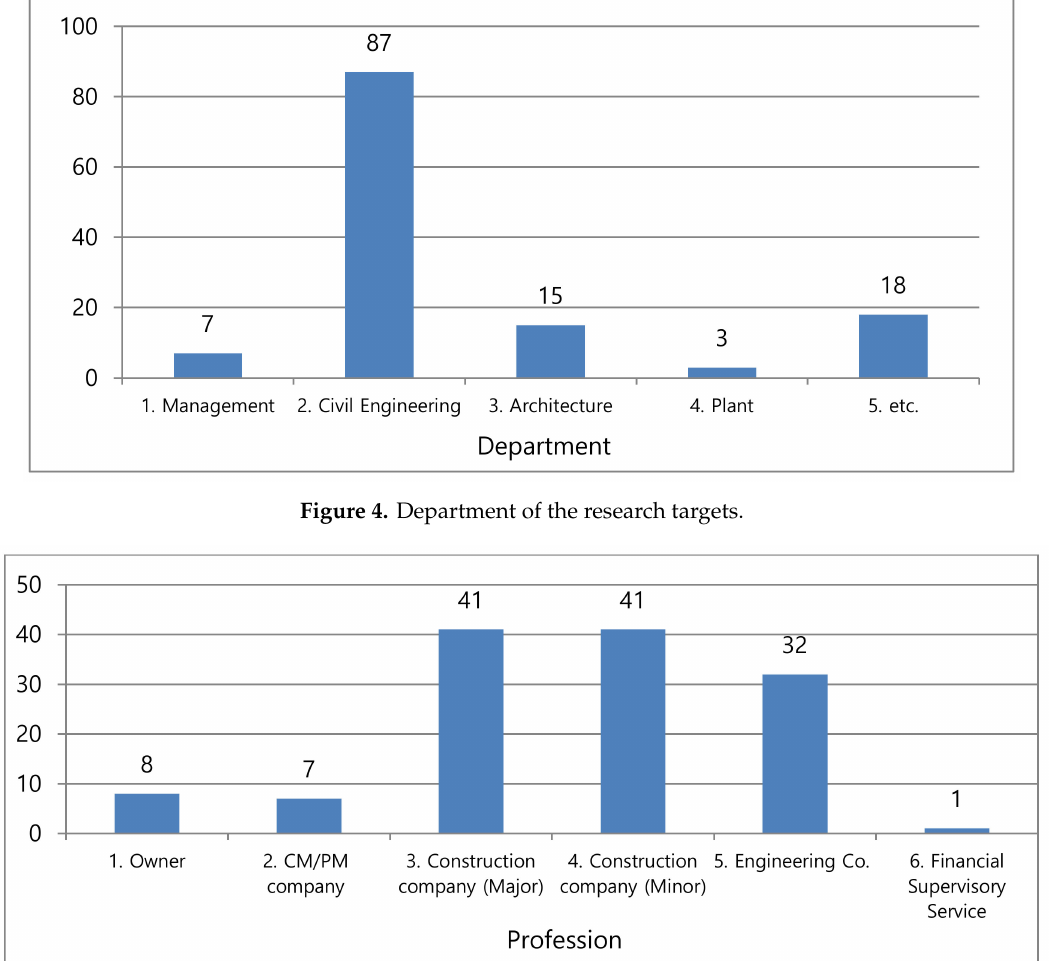
Figure 5. Profession of the research